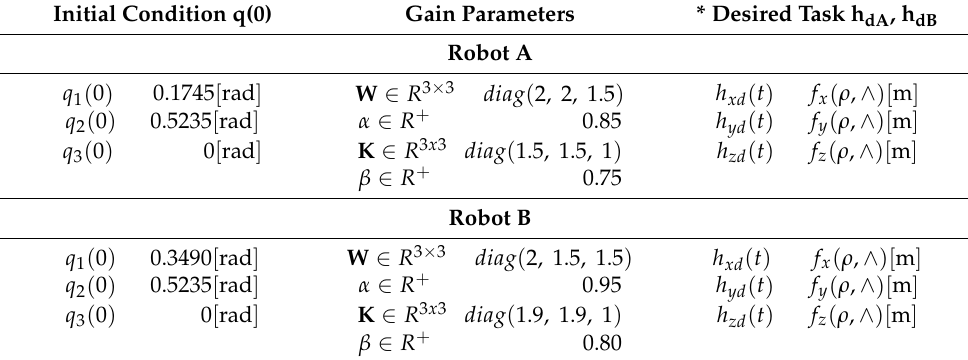
Table 2. Desired task and initial